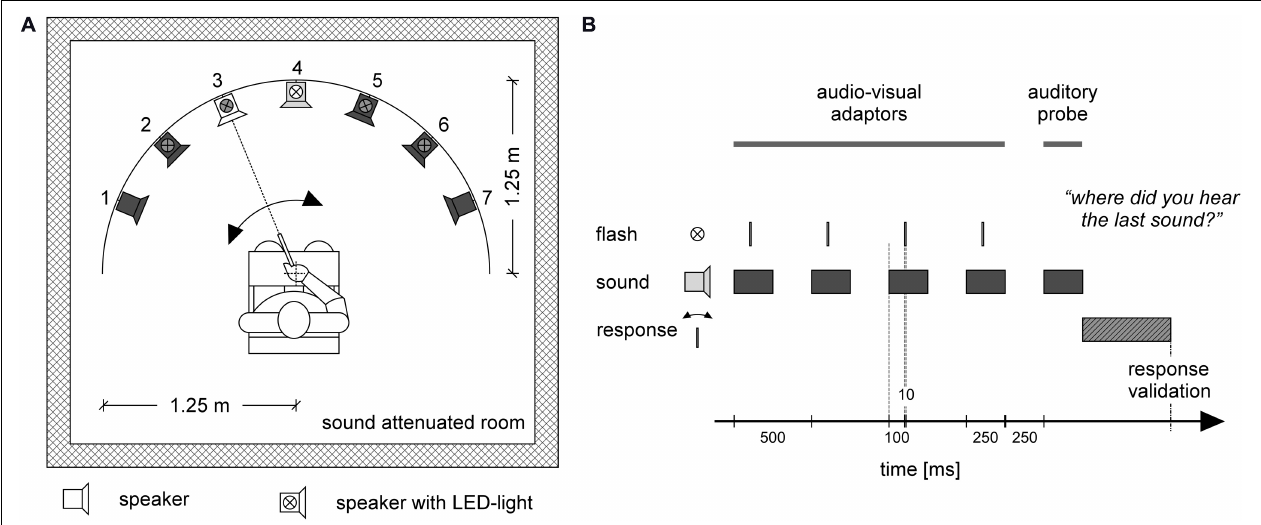
FIGURE 1 | Experimental setup (A) , and stimulus and response timing (B) . Participants were placed in a sound attenuated room. Seven loudspeakers were placed in front of the participant in a sector covering 135 ◦ of a circle with a radius of 1.25 m. The participant was sitting at the center of the circle (A) . In each trial (B) four audio-visual adaptor stimuli were provided from one loudspeaker together with a flashlight (LED) mounted on top of the loudspeaker. In the depicted example, (A) the four adaptor stimuli occur at loudspeaker 4 (loudspeaker in light gray) together with the LED flash presented at the same location (white LED symbol). The series of adaptor stimuli were followed by an auditory-only probe stimulus (B) that could occur either at the same position as the adaptor stimuli or at a neighboring location. In the example (A) the probe is delivered at position 3 (white loudspeaker). Inactive loudspeakers and LEDs for that trial are depicted in dark gray (A) . Participants used a pointing device to indicate the direction of the probe stimulus (A) . After moving the pointer in the direction of the sound source, the participant pressed a button on the pointing device to validate their response (B)